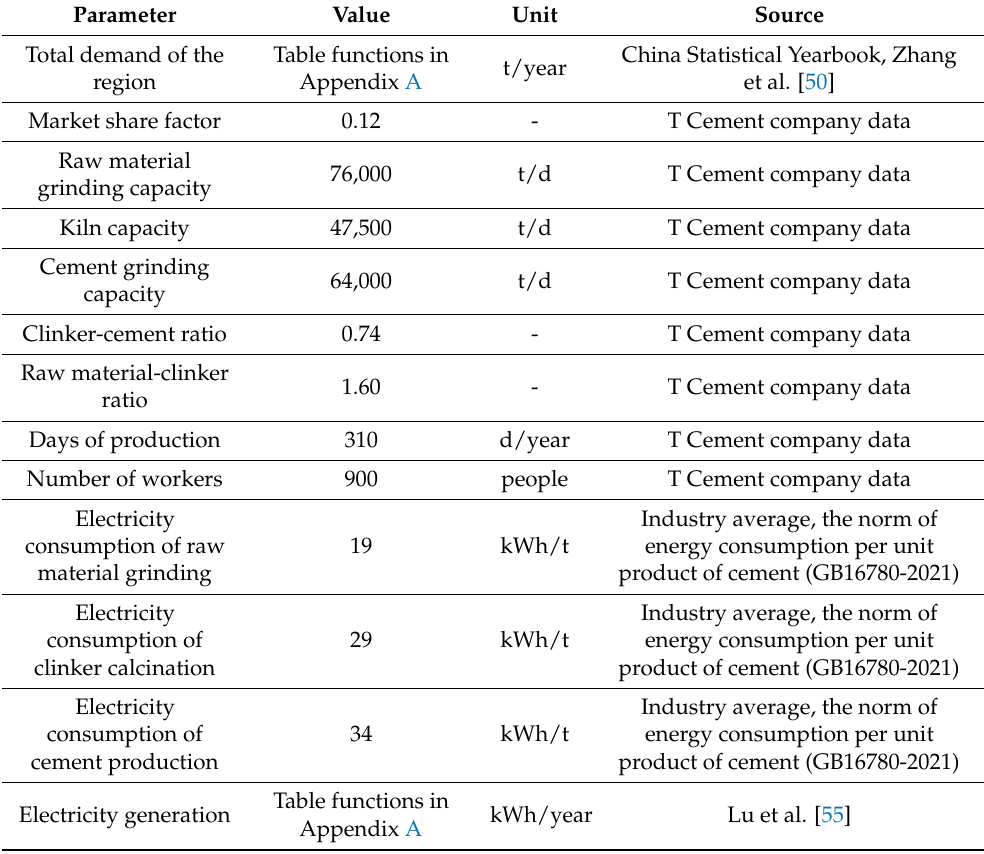
Table A1. The parameters of demand and production